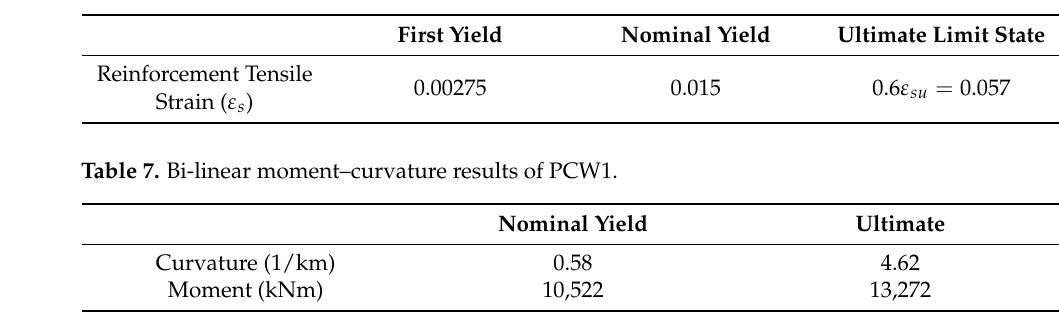
Table 6. Material strain limits for moment–curvature analyses of the case study precast walls.